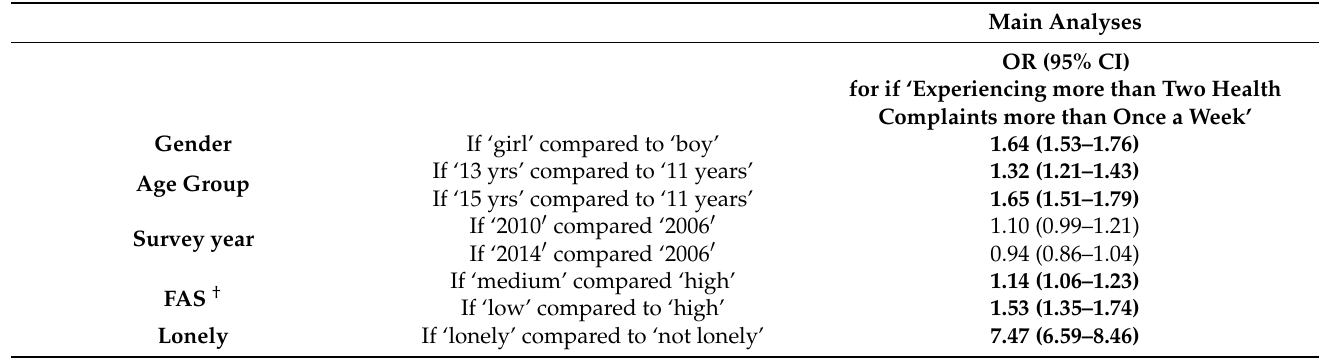
Table 4. MLM logistic regression—Predictors of multiple health